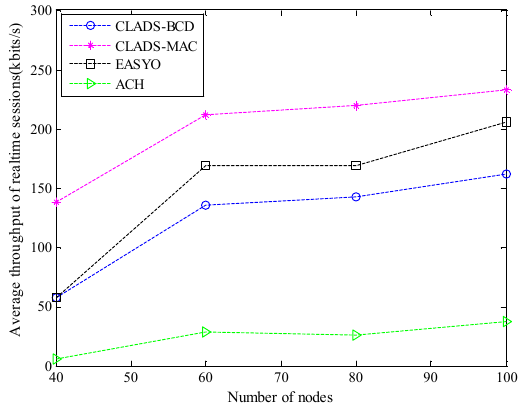
Figure 5. Average throughput of real-time sessions under different number of nodes.